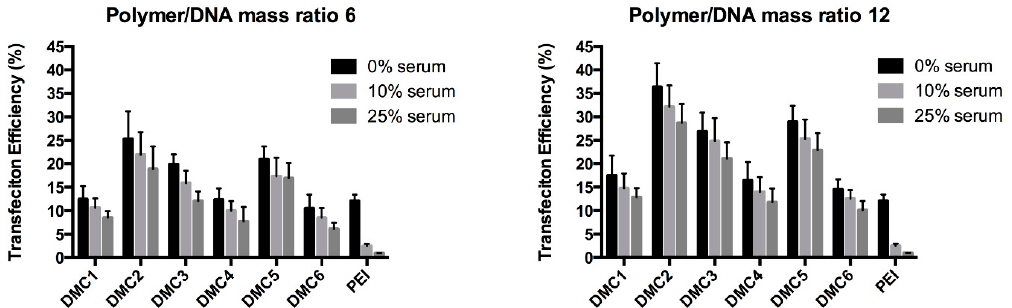
Figure 5. Transfection efficiencies of polyplexes prepared from bioreducible PAEs DMC1-6 and plasmid DNA at polymer/DNA mass ratios of 6 ( left ) and 12 ( right ). PEI is included as a reference at its optimal ratio of N/P = 10 in both graphs. COS-7 cells were exposed to polyplexes for 1 h and were incubated using various serum concentrations for 2 days. Transfection efficiency was quantified using FACS.